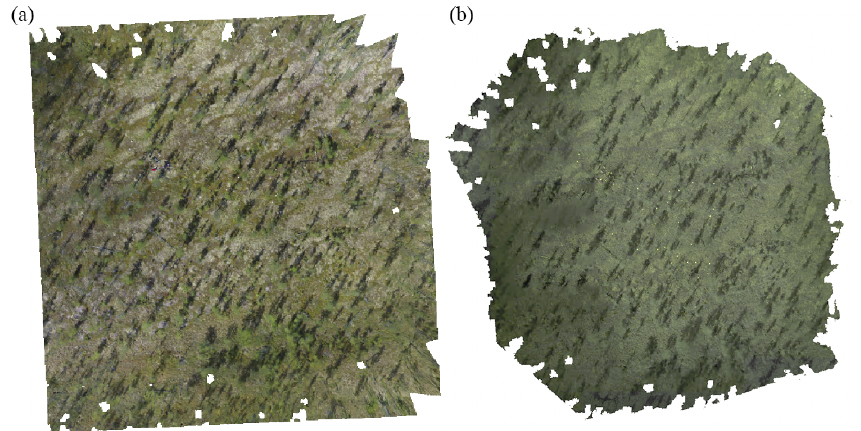
Figure 5. Example of red–green–blue (RGB, displayed with red on red, green on green and blue on blue as true color) (a) and red–green– near-infrared (RGN, displayed with green on red, NIR on green, and red on blue) (b) orthomosaics for plot EN18000.